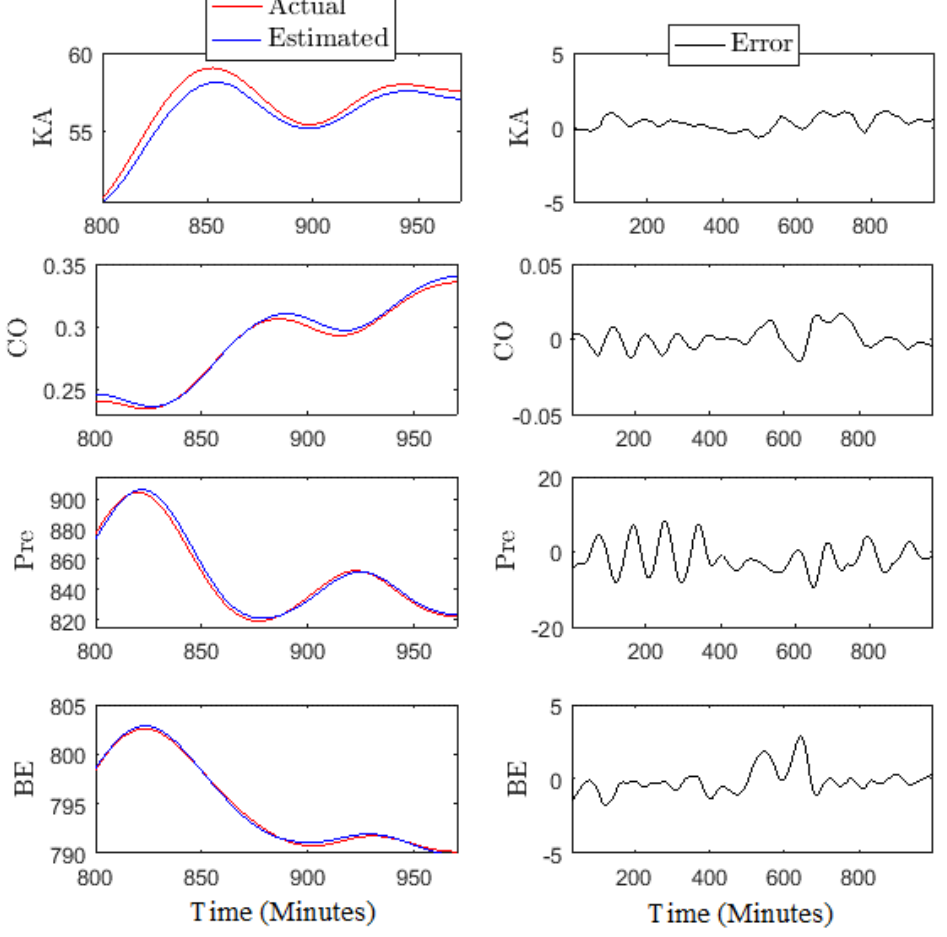
Figure 5. Actual and estimated outputs and errors of the outputs of CRK in the identification by SGD-based RMLP